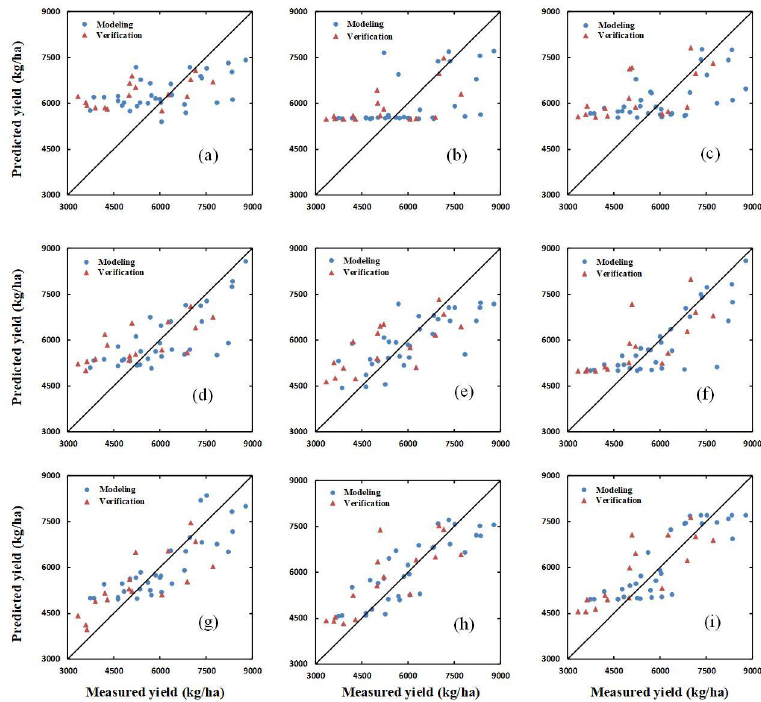
Figure 7. The relationships between the ground-measured and predicted values of winter-wheat yield at different growth stages based on an artificial neural network (ANN). ( a ), ( b ), and ( c ) show the results for SIs, a combination of SIs and H, and a combination of SIs and H CSM , respectively, at the jointing stage. ( d ), ( e ), and ( f ) show the same as ( a ), ( b ), and ( c ) for the flagging stage; and ( g ), ( h ), and ( i ) show the same as ( a ), ( b ), and ( c ) for the flowering stage.